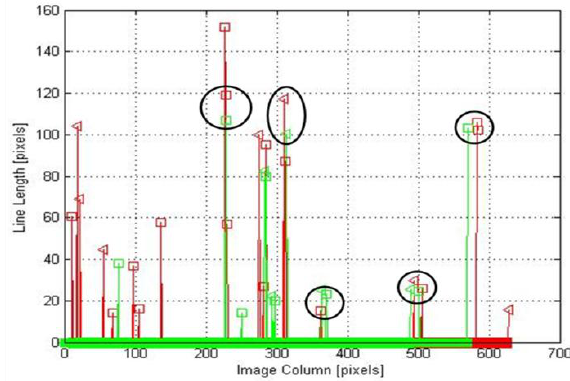
Figure 11. Corresponding Vertical Line Features between the video frame (red) and synthetic image (green) are circled